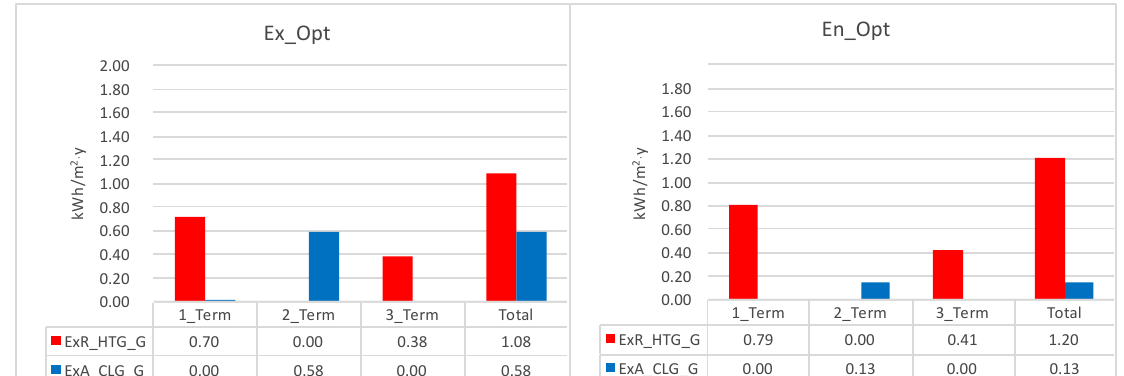
Figure 13. Exergy analysis in the ground